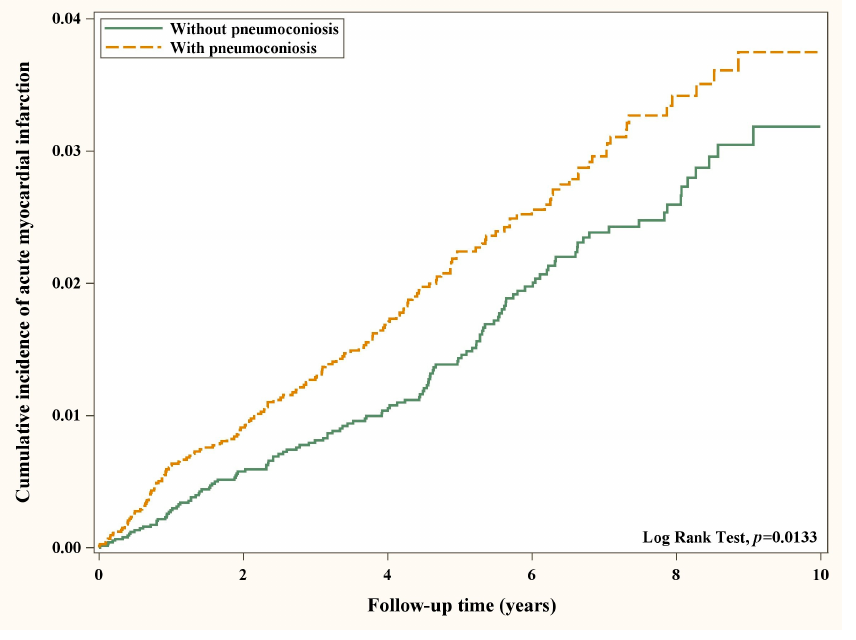
Figure 2. Cumulative incidence of acute myocardial infarction in the pneumoconiosis cohort (PC) and comparison cohort (CC). Table 2. Risk factors of acute myocardial infarction among the study